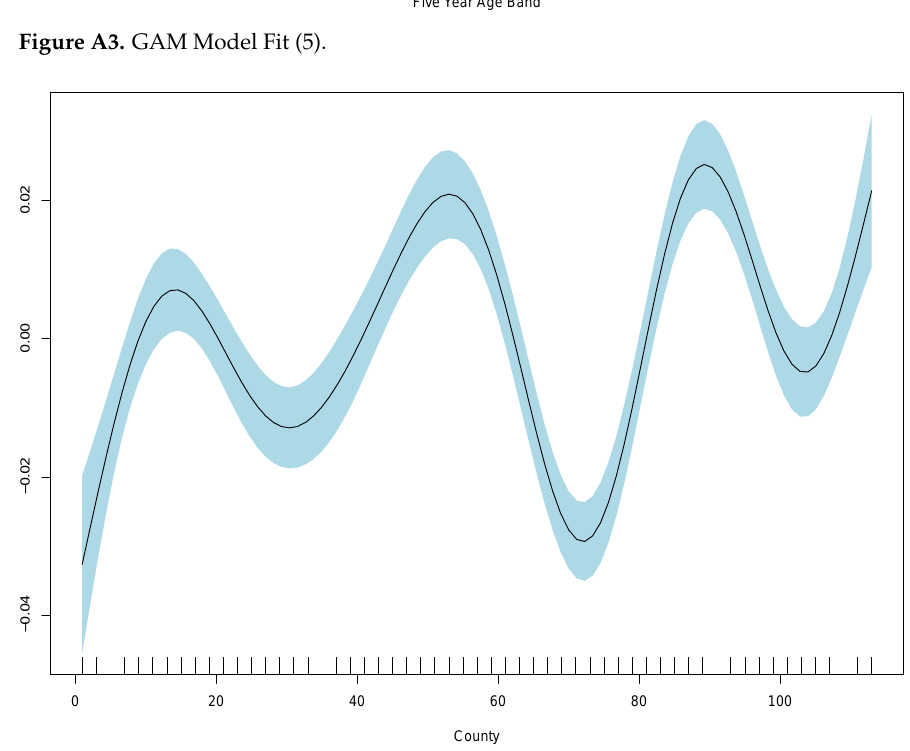
Figure A4. GAM Model Fit